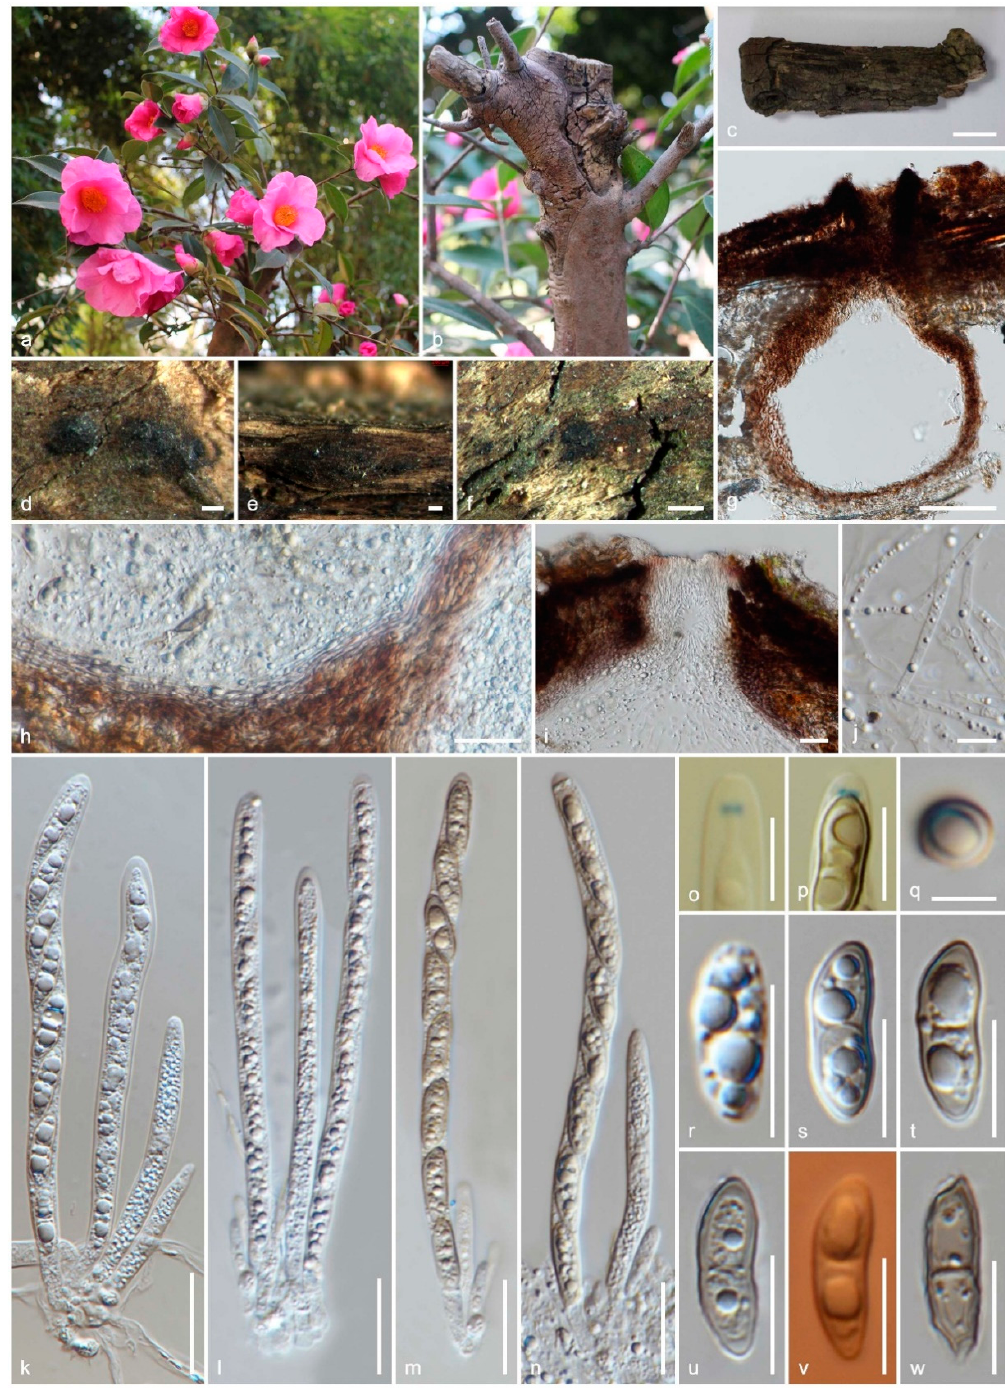
Figure 3. The sexual morph of Amphisphaeria camelliae (HKAS 107021, holotype). ( a , b ) Host Camellia japonica ; ( c ) substrate; ( d – f ) ascomata on the substrate; ( g ) vertical section of ascoma; ( h ) peridium; ( i ) ostiole; ( j ) paraphyses; ( k – n ) asci; ( o , p ) apical ring bluing in Melzer’s reagent; ( q ) ascospore top view; ( r – w ) ascospores (v in Congo Red). Scale bars are set at ( c ) 1 cm; ( f ) 500 μ m; ( d , e ) 200 μ m; ( g ) 100 μ m; ( h , i , k – n ) 20 μ m; ( o , p , r – w ) 10 μ m; ( q ) 5 μ m.